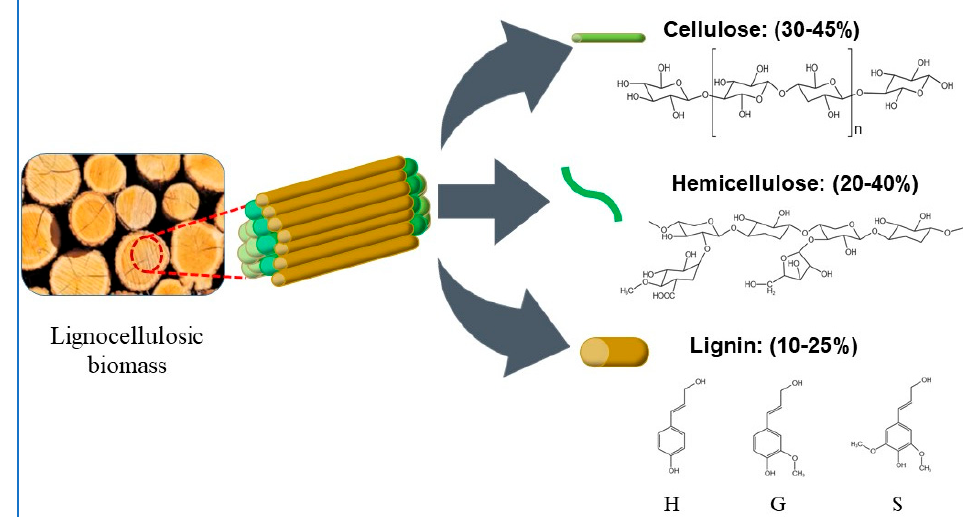
Figure 1. Structural compositions of lignocellulosic biomass.